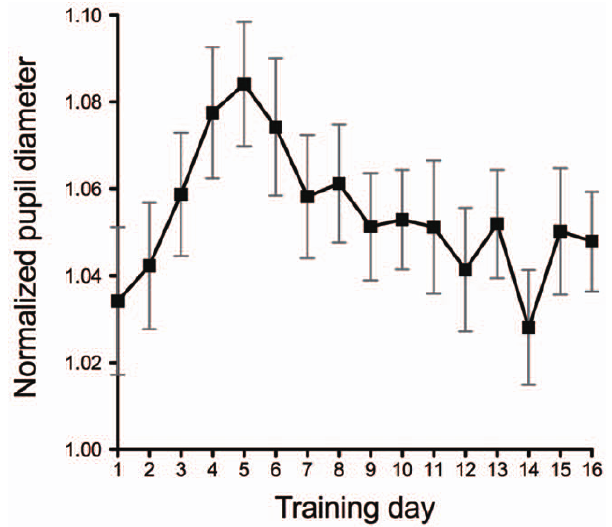
Figure 5. Normalized pupil diameter 1 second after the onset of the visual search display. Filled squares denote the averaged pupil diameter of 12 subjects 1 second after the onset of the visual search display, as a function of the training day. The data was calculated from Fig. 3(A). Error bars represent 6 1SEM.